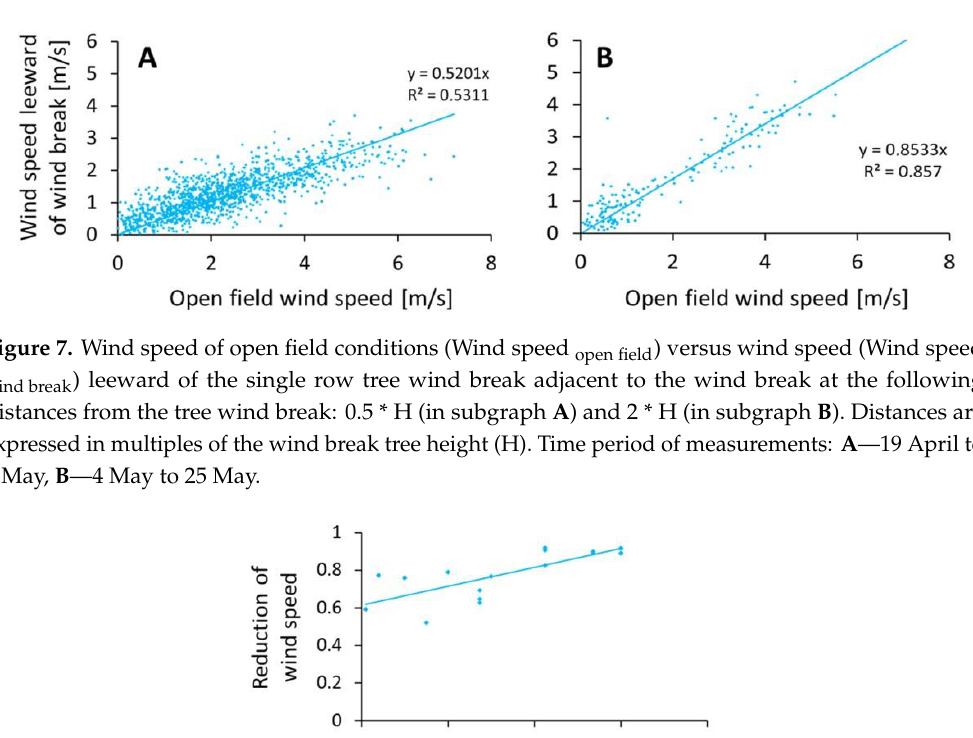
Figure 7. Wind speed of open field conditions (Wind speed open field ) versus wind speed (Wind speed wind break ) leeward of the single row tree wind break adjacent to the wind break at the following distances from the tree wind break: 0.5 * H (in subgraph A ) and 2 * H (in subgraph B ). Distances are expressed in multiples of the wind break tree height (H). Time period of measurements: A — 19 April to 3 May, B — 4 May to 25 May.